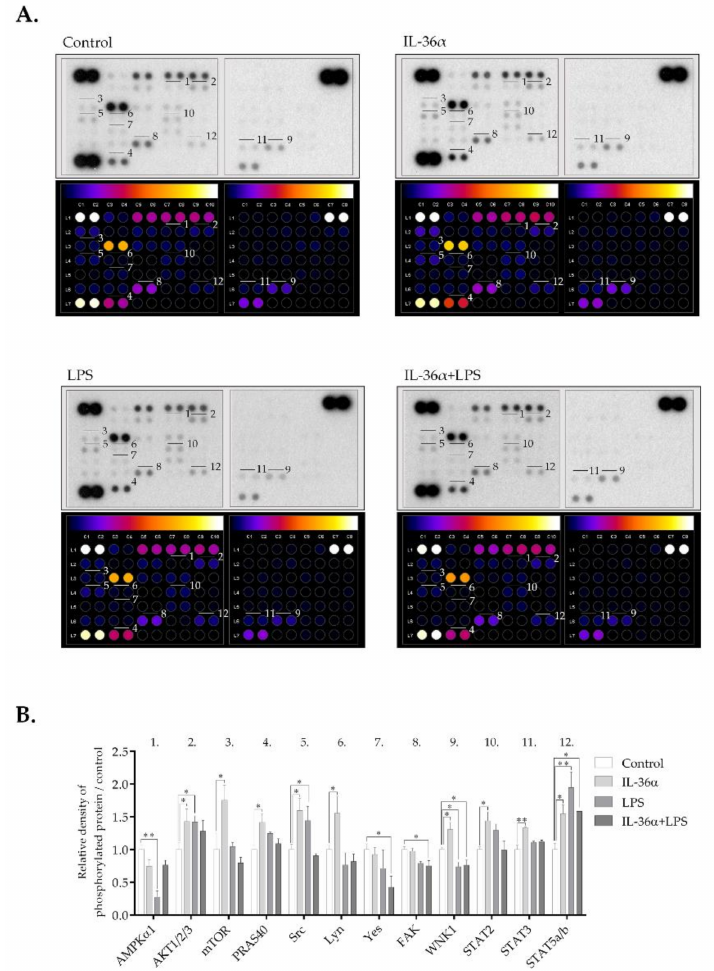
Figure 6. Differential phospho-kinase array profiles of cells treated with IL-36 α and LPS. ( A ) Phospho- kinase array analysis. Total protein was isolated from THP-1 cells treated with IL-36 α , and LPS alone or in combination for 30 min. Control cells were left untreated. The samples were hybridized with a phospho-kinase array kit. The labeled spots correspond to the phospho-proteins modulated by IL-36 α and LPS. ( B ) Quantification of phosphoproteins from the proteomic array (average of duplicate spots). Spot densities of phosphoproteins were quantified using Image J analysis software and normalized to positive controls on the same membrane. p values were calculated by the ANOVA test with the Sidak post-test. * p < 0.05; ** p <